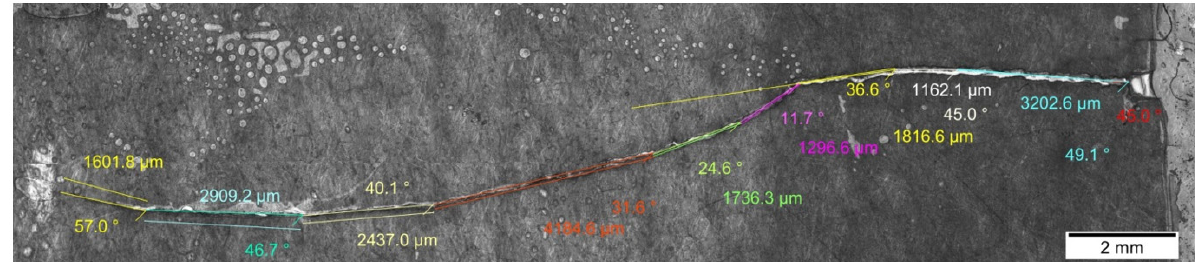
Figure 3: Illustration of the varying crack path angle on an acetate surface replica for specimen SP5A with an initial 45° slit. The arrow indicates the direction of the applied load during the crack growth under biaxial